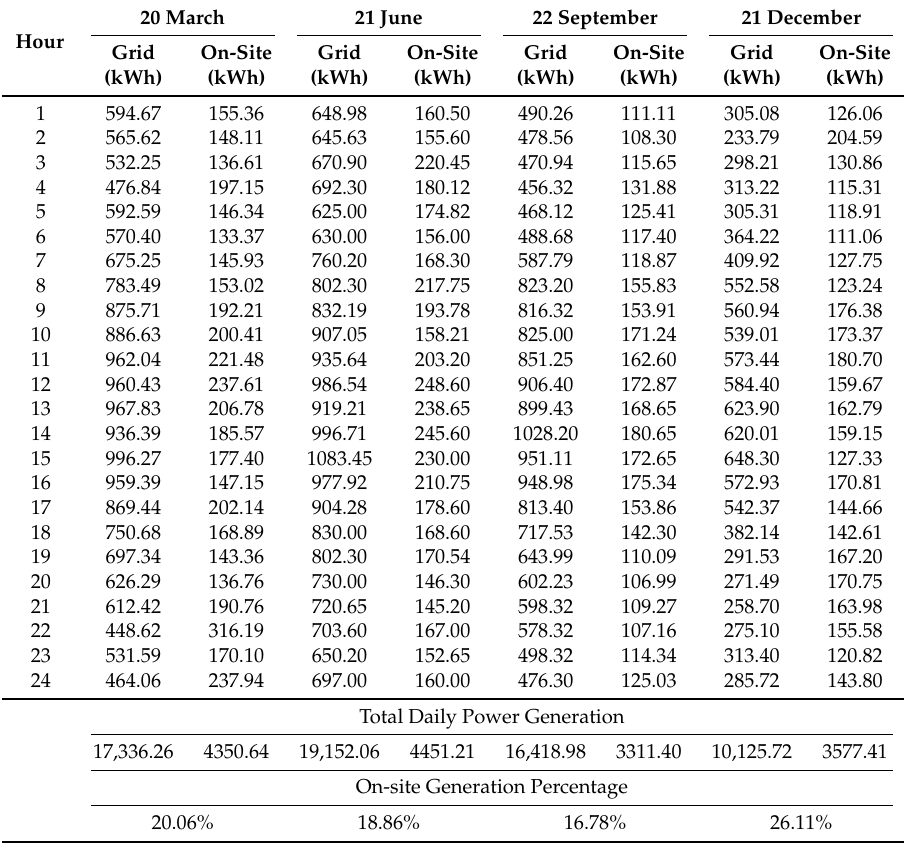
Table 4. Purchased power and average on-site power generation on four different example days.